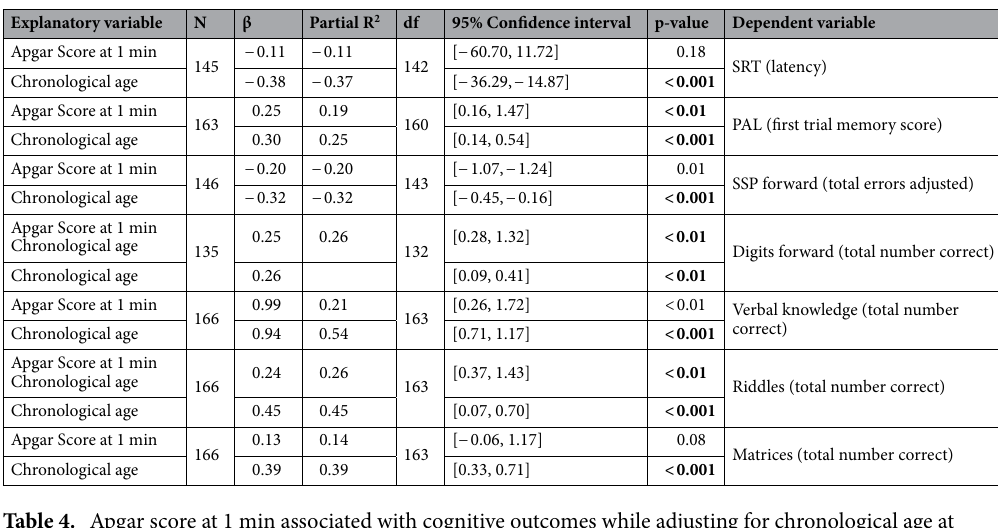
Table 4. Apgar score at 1 min associated with cognitive outcomes while adjusting for chronological age at time of cognitive testing: results from regression analyses. N sample size, R coefficient of correlation, df degrees of freedom, SRT simple reaction time, PAL paired-associates learning, SSP spatial Span, Digits Forward recall of digits forward. Bolded p-values are those which remained significant after Bonferroni correction (p ≤ 0.007) for multiple comparisons. Confidence interval corresponds to the unstandardized coefficient.